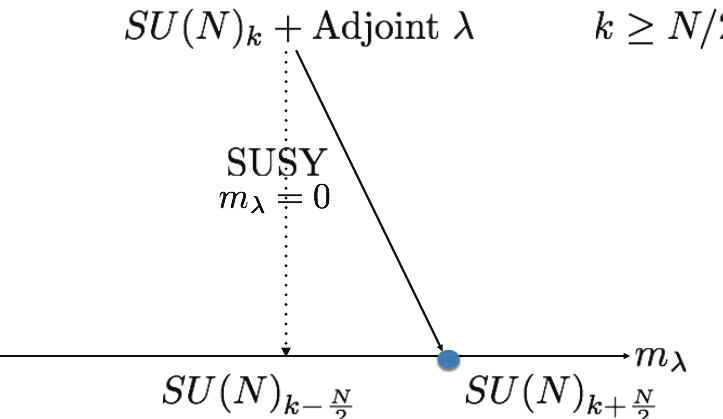
Figure 4: The phase diagram of SU ( N ) with an adjoint fermion for k ≥ N / 2. Note k that the physics at the supersymmetric point is smooth. For k = N / 2 the negative mass phase is trivial. In that case the transition is still to the right of the supersym- metric point.